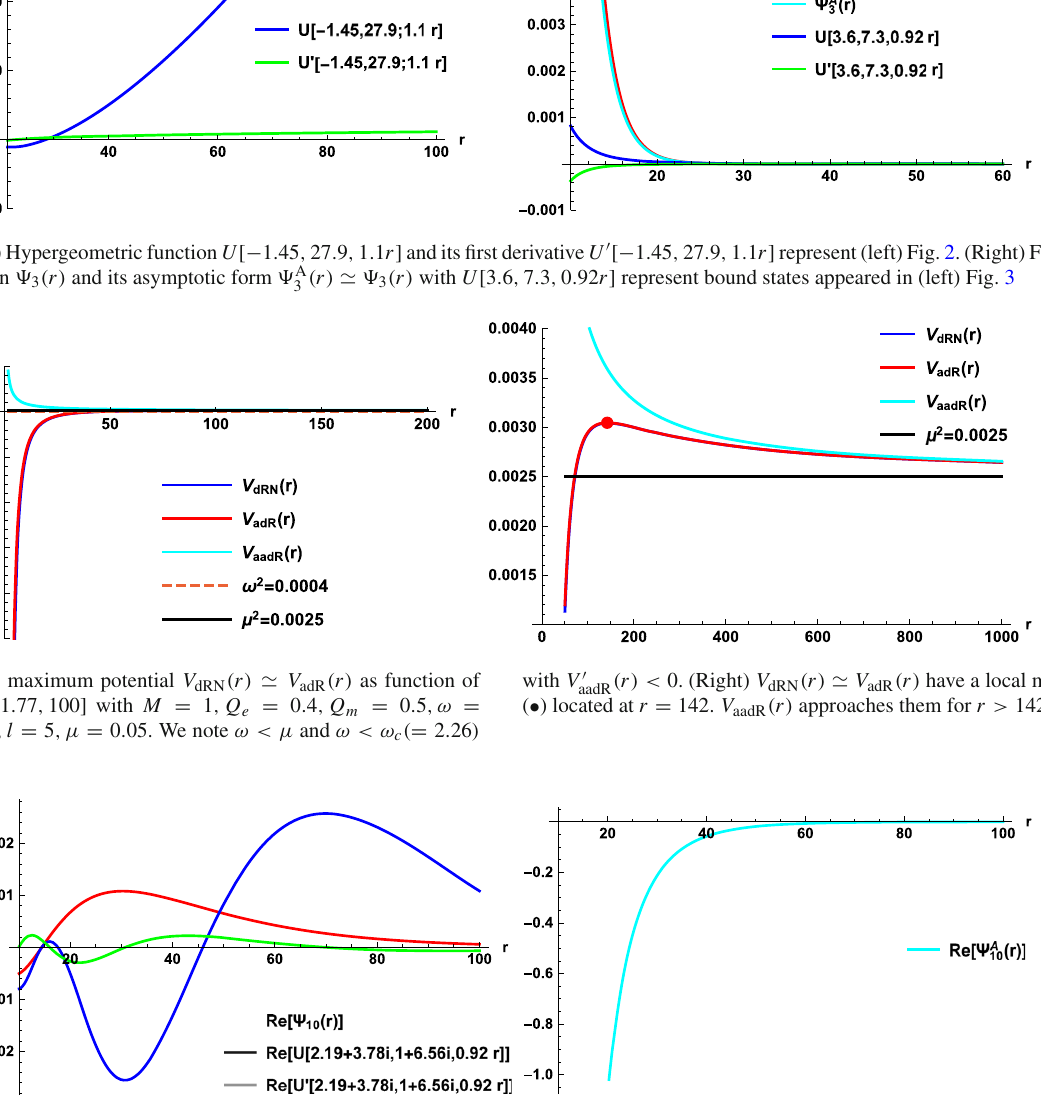
Fig. 6 (Left) Oscillating function Re[ (cid:17) 10 ( r ) ] with Re[ U [ 2 . 19 + 3 . 78 i , 1 + 6 . 56 i ; 0 . 92 r ]] and Re[ U (cid:15) [ 2 . 19 + 3 . 78 i , 1 + 6 . 56 i ; 0 . 92 r ] ] for (left) ( r ) ] represents a negative bound state Fig. 5. (Right) Its asymptotic wave function Re[ (cid:17) A 10 10 . 5 r ] is zeronearly( a (cid:17) 0). This caserepresents aboundary between trapping well ( a < 0) and no trapping well ( a >